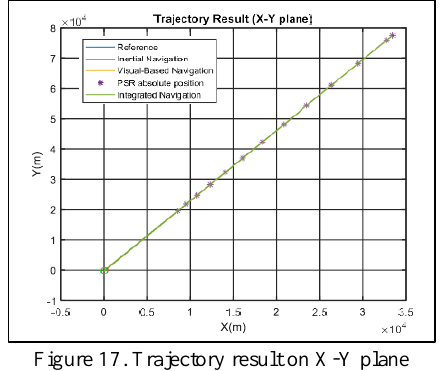
Figure 17. Trajectory result on X-Y plane